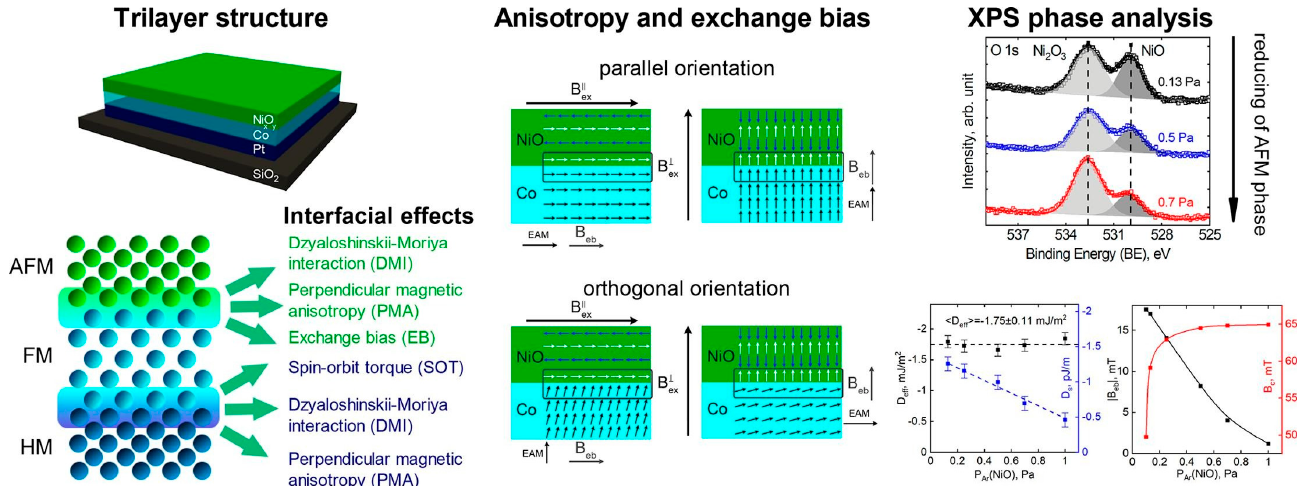
Figure 5. Effects possibly occurring in a trilayer structure of AFM, FM and heavy metal (HM): Dzyaloshinskii–Moriya interaction, exchange bias, spin-orbit torque in the FM and perpendicular magnetic anisotropies in the system NixOy/Co/Pt. Reprinted with permission from [69], Copyright 2021 Elsevier.